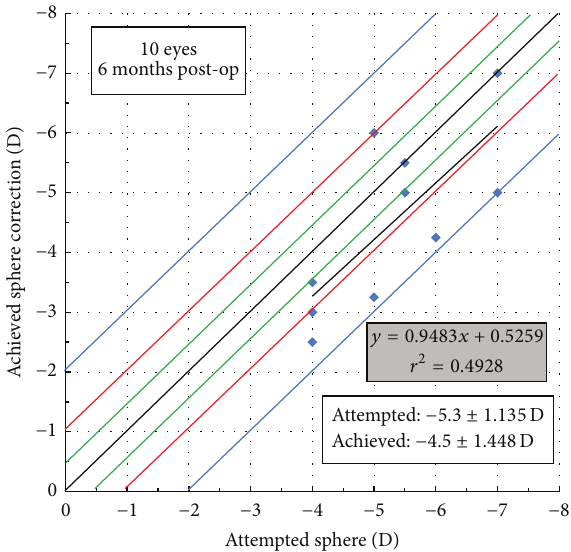
Figure 1: Attempted versus achieved spherical correction 6 months postoperatively.